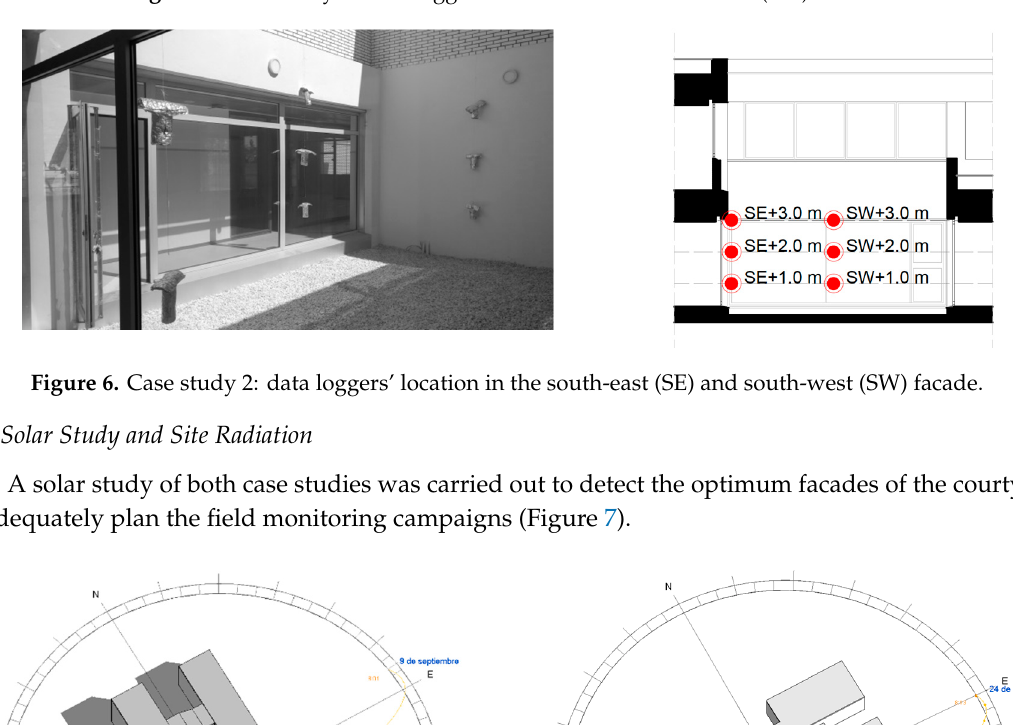
Figure 5. Case study 1: data loggers’ location in the south-west (SW) facade.